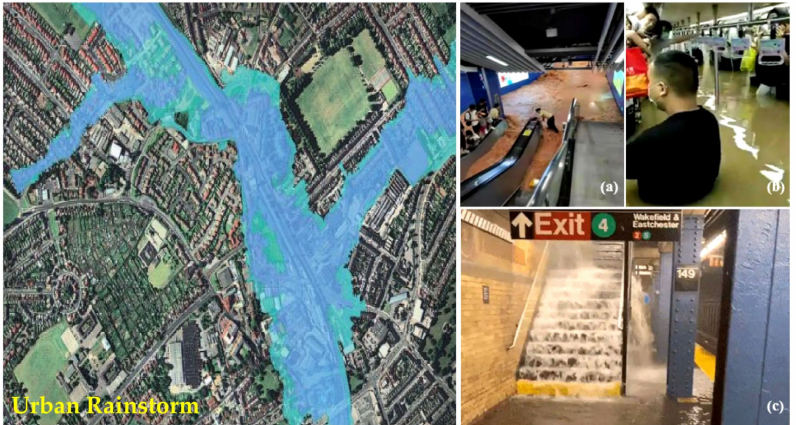
Figure 1. The metro stations were flooded. ( a ) Shenzhoulu station of Guangzhou metro line 21 on 30 July 2021. ( b ) Station of metro line 5 flooded during heavy rainfall on 18 July 2021, in Zhengzhou. ( c ) The New York metro station was attacked on 2 September